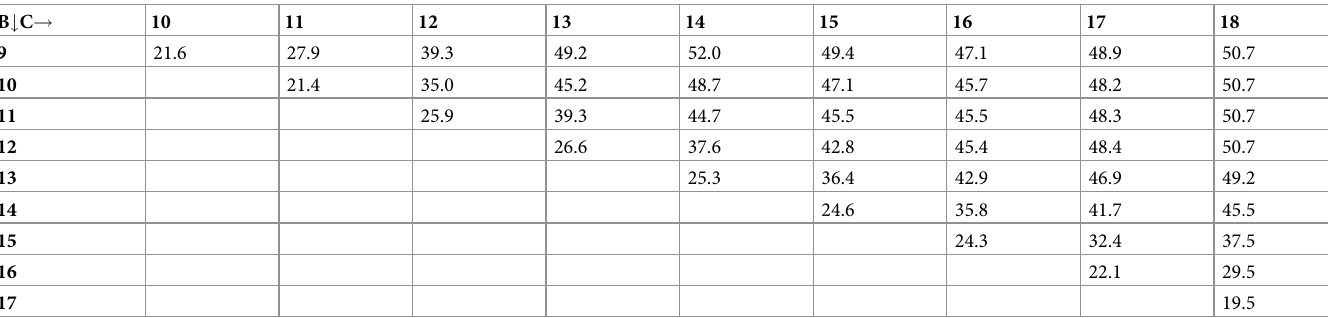
To make the forecasts of the GCC method publicly available, we developed a website appli- cation where the user can input a time series of heights to get the year-by-year forecast. The application is accessible at https://en.slofit.org/measurements/height-prediction. Fig 4 shows an example forecast for a 13-year-old boy of average height. The left panel shows that a predic- tion based on only two measured heights (at age 12 and 13), which does not allow PHV identi- fication, results in the final height of 180 cm. The prediction is improved with the increasing number of data points, which is shown through 2 scenarios for the same 13-year-old in the right panel of the Fig 4. In Scenario A, the PHV has occurred at age 12, which estimates the final height of 177 cm, while in Scenario B, the PHV has not yet occurred which results in the final estimated height of 183 cm. Hence, a forecast in the scenario when the PHV cannot be identified is an approximate average of the predicted final heights in scenarios when the PHV has already occurred and when the PHV is yet to occur. Tables 3 and 4 list the 95% confidence intervals (CI) (which equals double standard devia- tion) for predictions using the height values between two ages. The reader should be careful Table 3. 95% confidence interval (in mm) for forecasting the height at the age C for boys using the values from the age of 8 to the age B. B # C